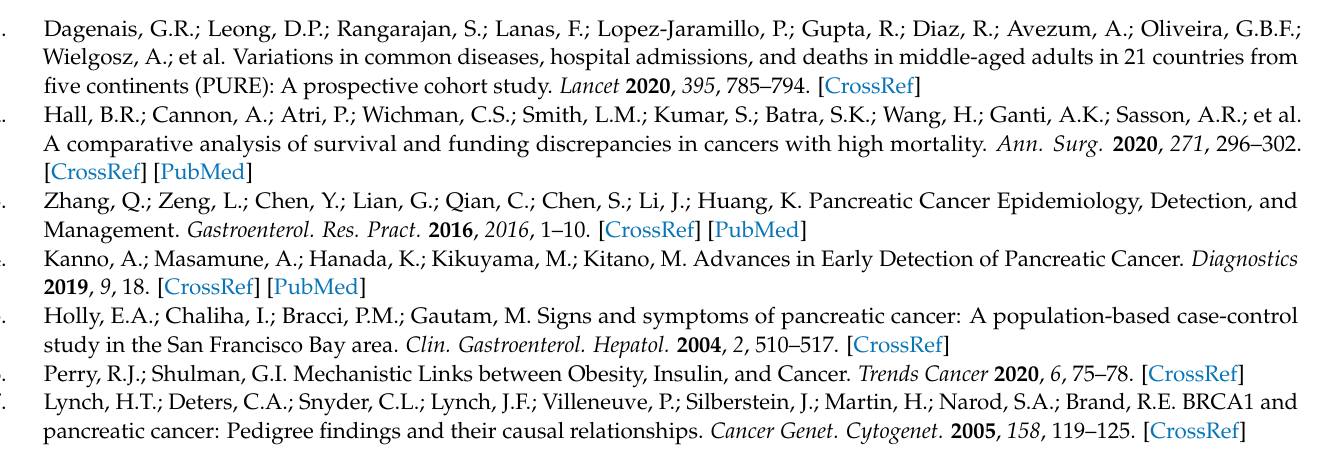
healthy subjects. Table S2: Comorbidities and TNM stage according to AJCC 8th edition in PDAC patients. Table S3: Comorbidities and baseline surgical pathology in the healthy subjects. Figure S1: Global correctness of the test obtained by linear discriminant analysis for each possible couple of parameters. Figure S2: Scatter plot for the best couple of